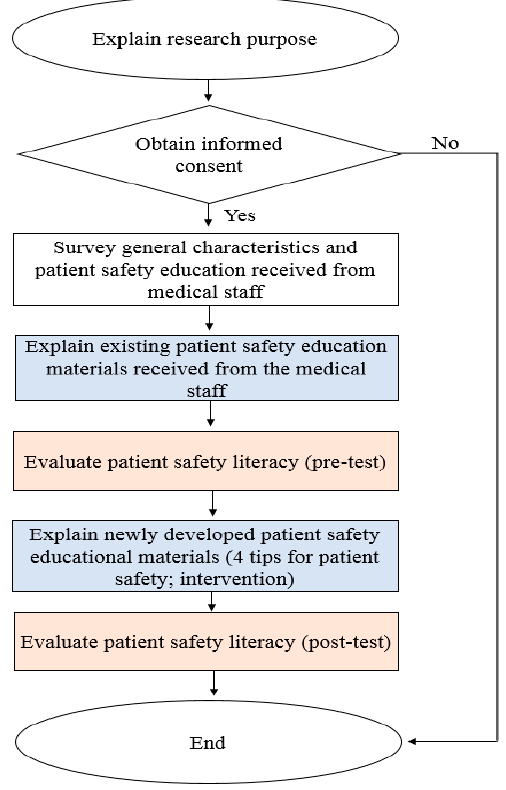
Figure 1. Flow of survey process.